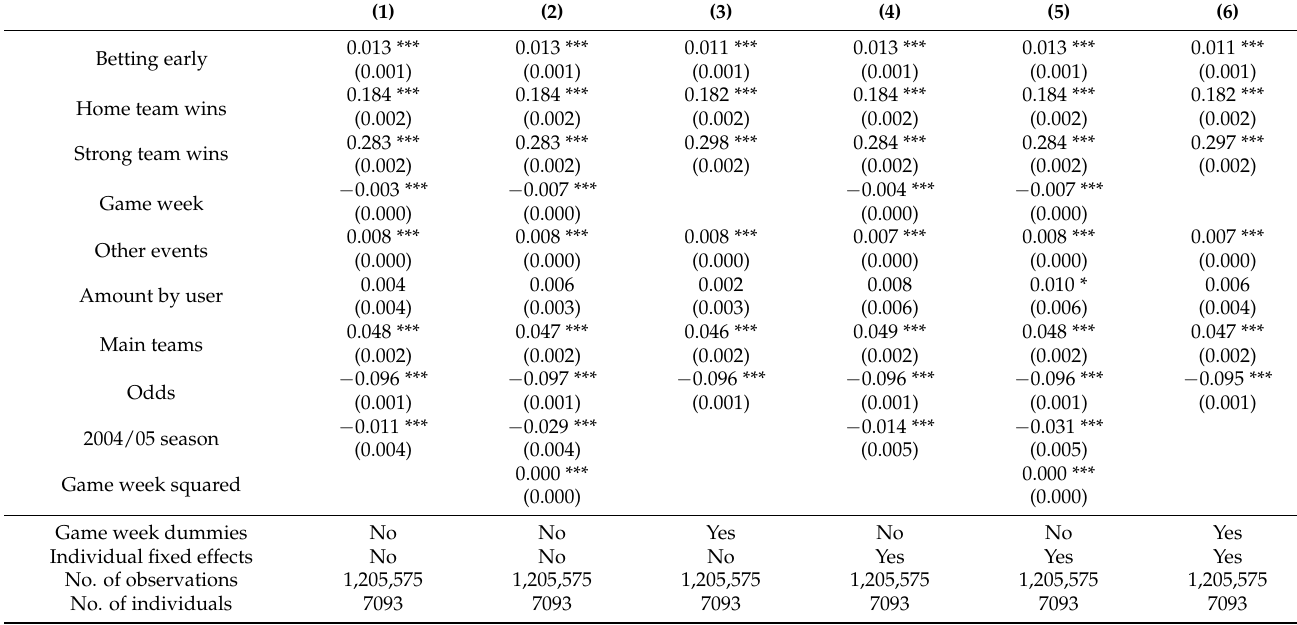
Table 4. The impact of betting early: baseline